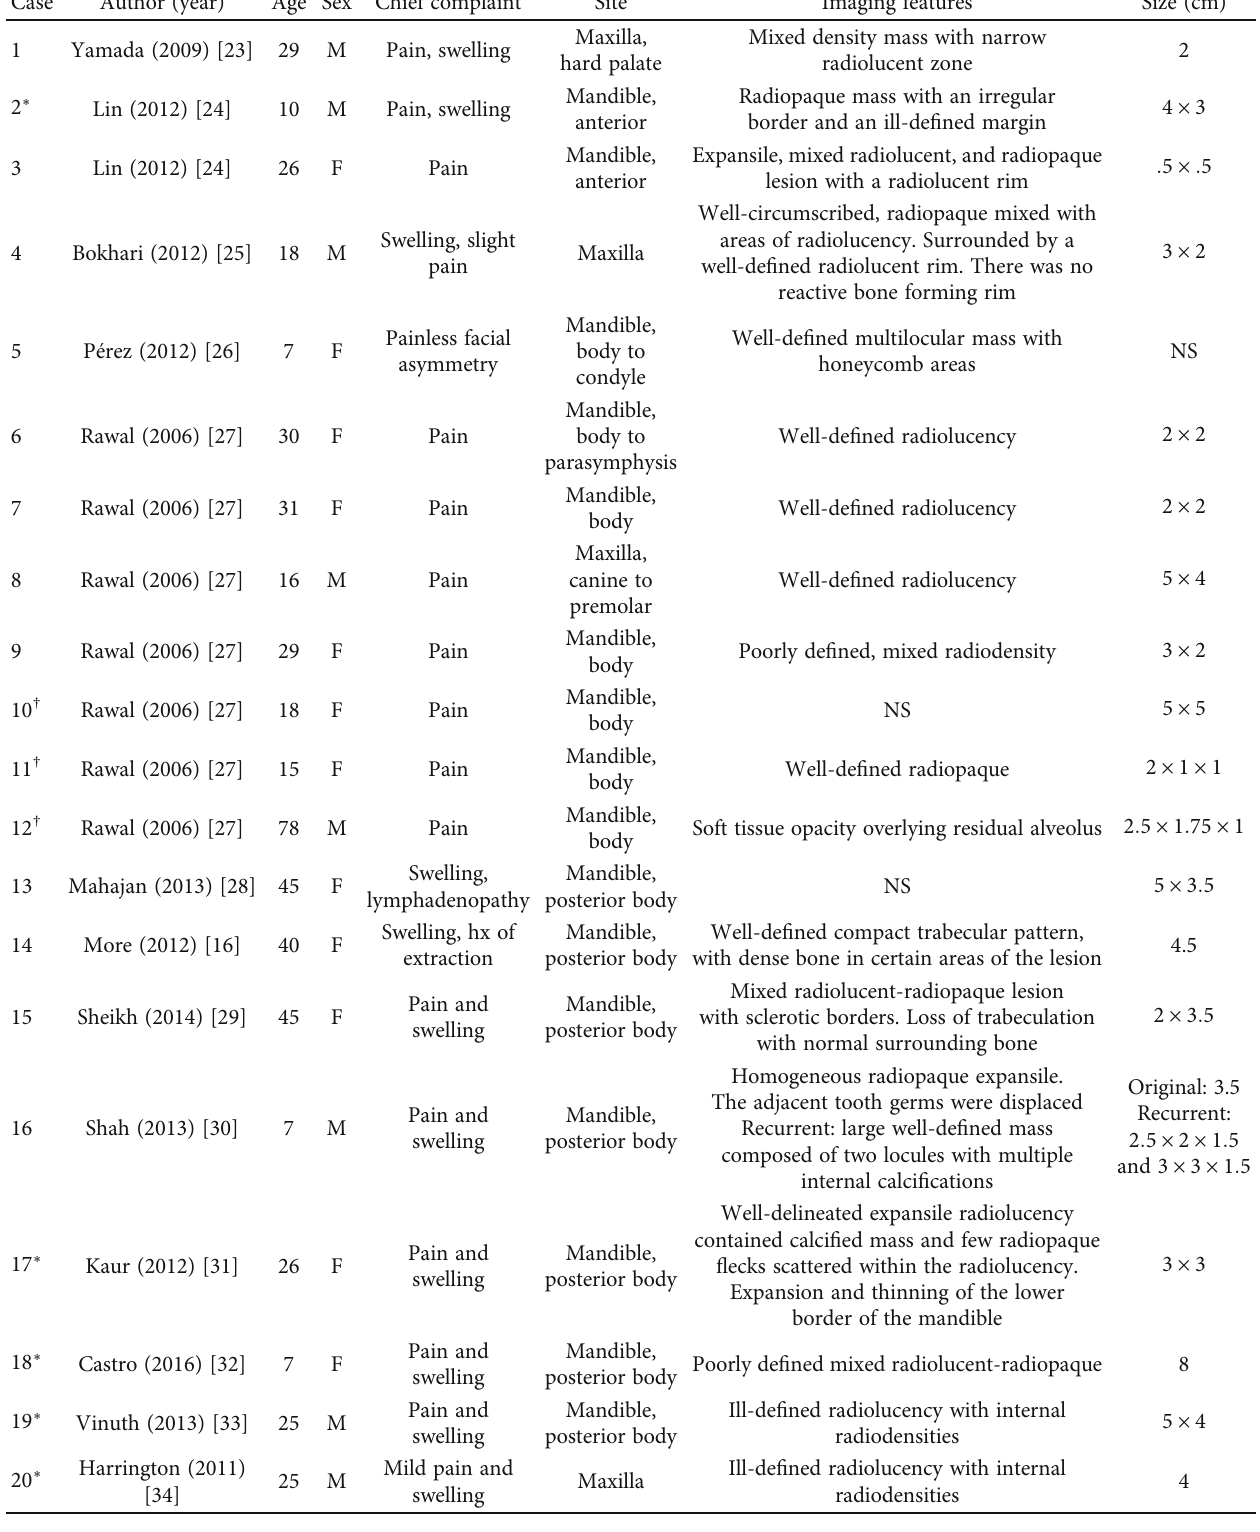
Table 2: Characteristics of previously reported osteoblastoma of the maxilla and mandible ( n = 29 ).